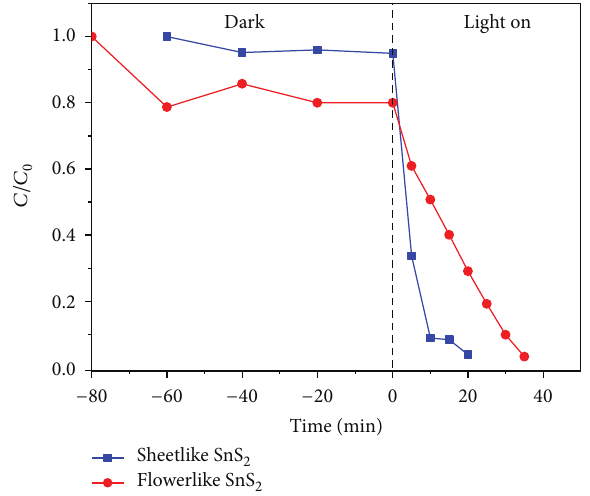
Figure 6: Variation of the MO concentration shows the photocat- alytic degradation process over two photocatalysts (0.04g) during dark and upon visible light irradiation ( 𝜆 > 420